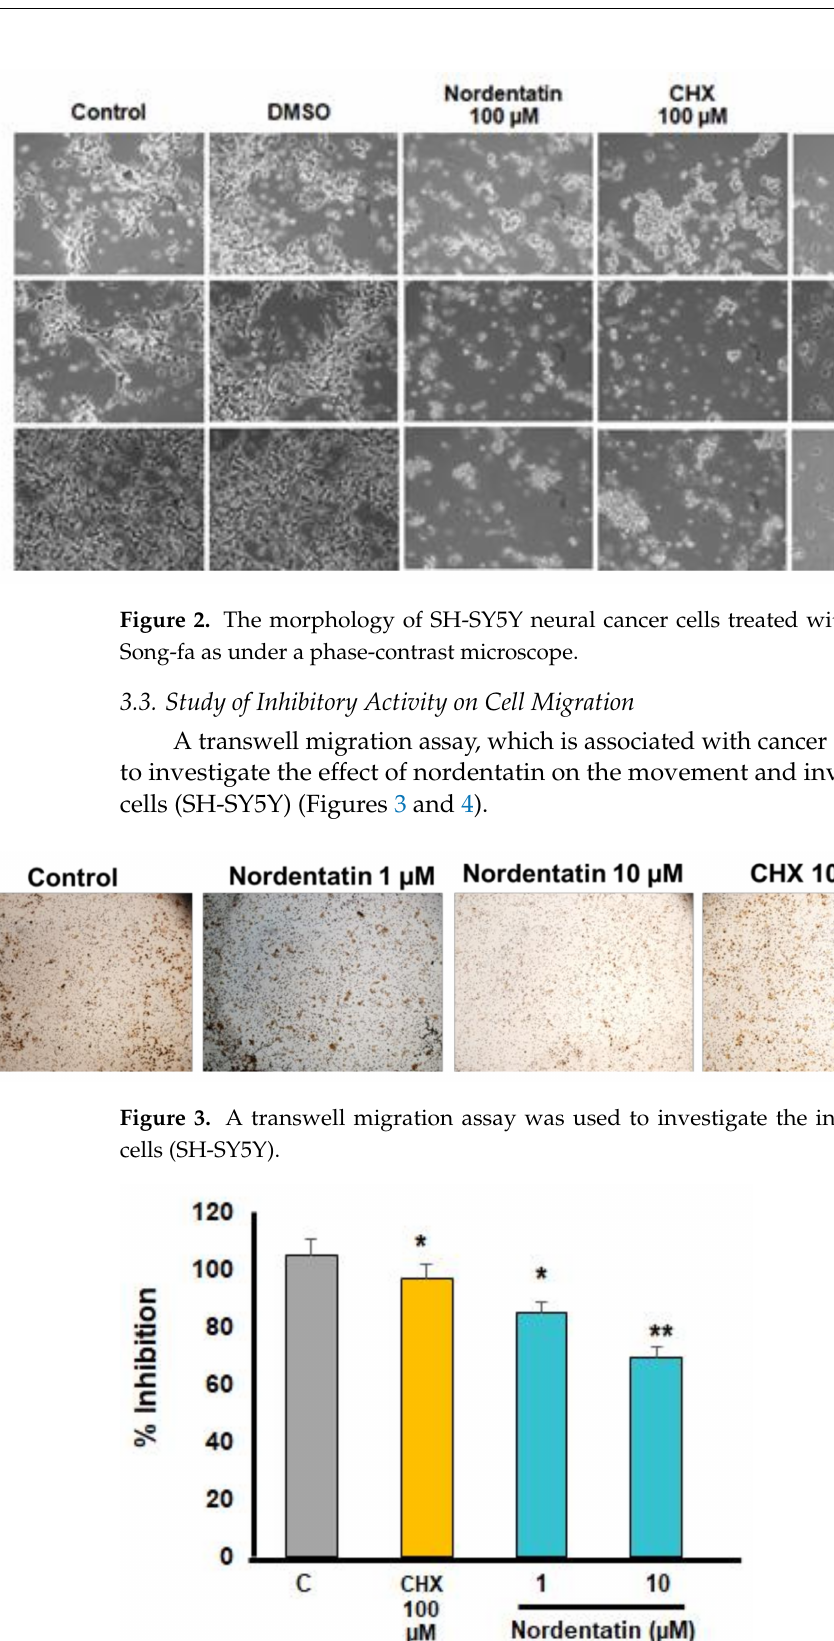
Figure 4. The percentage of neuroblastoma cells (SH-SY5Y) that were able to cross the membrane. The experiments were conducted in triplicate. * p < 0.05, ** p < 0.01 versus control